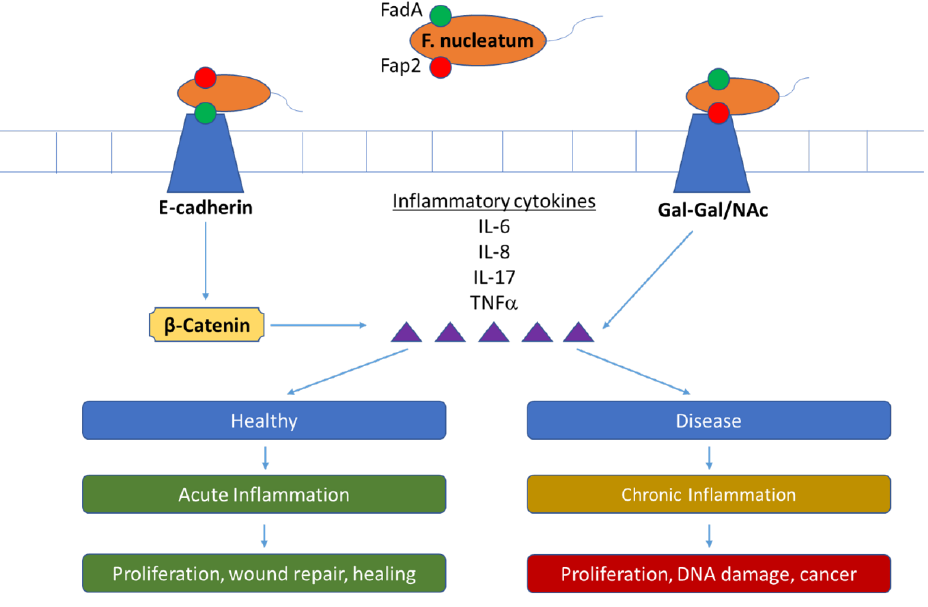
Figure 1. The role of Fusobacterium nucleatum in the inflammation and ultimately the increase in cell proliferation of host cells. Both FadA and Fap2 are encoded by F. nucleatum , and their individual pathways are also shown [130]. FadA utilizes the E-cadherin complex while Fap2 adheres to the galactose sensitive pathway through the use of N-acetylgalactosamine (Gal/NAc) [132]. F. nucleatum provokes a variety of host responses including the stimulation of IL-6, IL-8, IL-17, and TNF α [139]. During a healthy state, this inflammation leads to wound repair and healing. However, during a diseased state, this can lead to DNA damage and cancer.